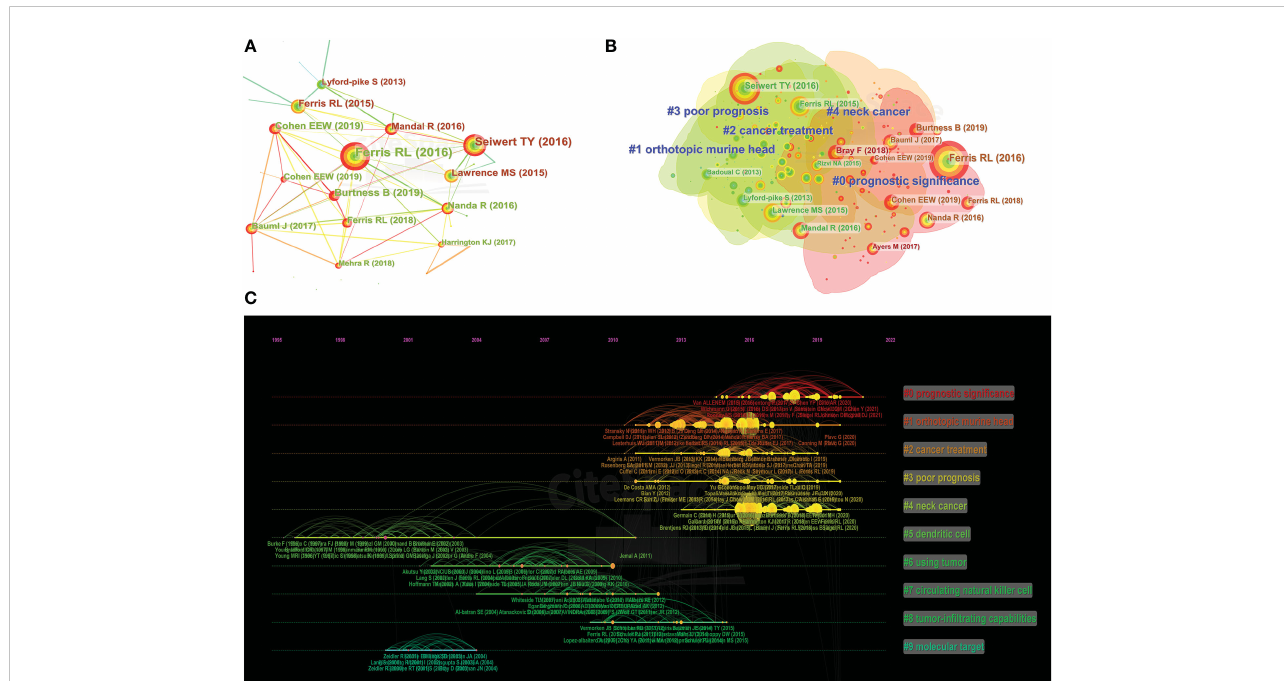
FIGURE 5 Co-cited references map (A) and clustered network map of co-cited references (B) on HNSCC immunotherapy research from 2000 to 2022. Each node ’ s diameter is proportional to the total number of co-citations for the connected article. The broad red circles outside the nodes suggested a high degree of centrality. The timeline view of the clusters that were co-cited along with their labels (C) . The nodes on the left represent older references, while the nodes on the right represent more recent references. A straight line in the same horizontal position indicates the set of all clustered references belonging, and the cluster label is located at the line ’ s rightmost